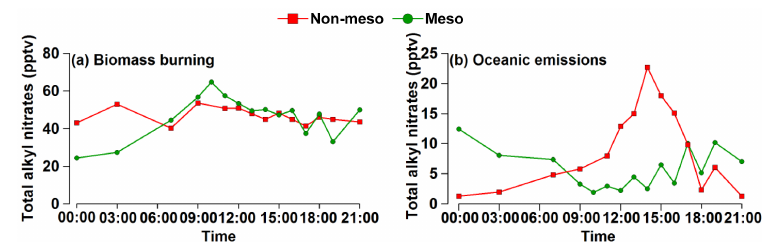
Figure 10. Diurnal patterns of (a) biomass burning and (b) oceanic emissions for meso and non-meso scenarios at